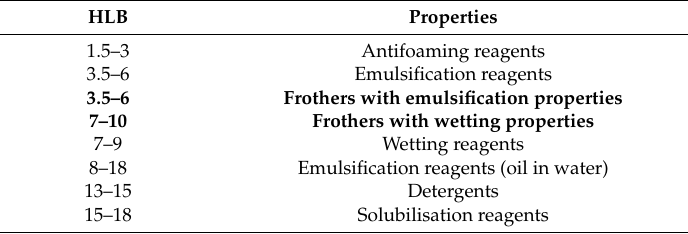
Table 4. Classification of organic reagents, including frothers, based on numerical value of HLB (after [21], with